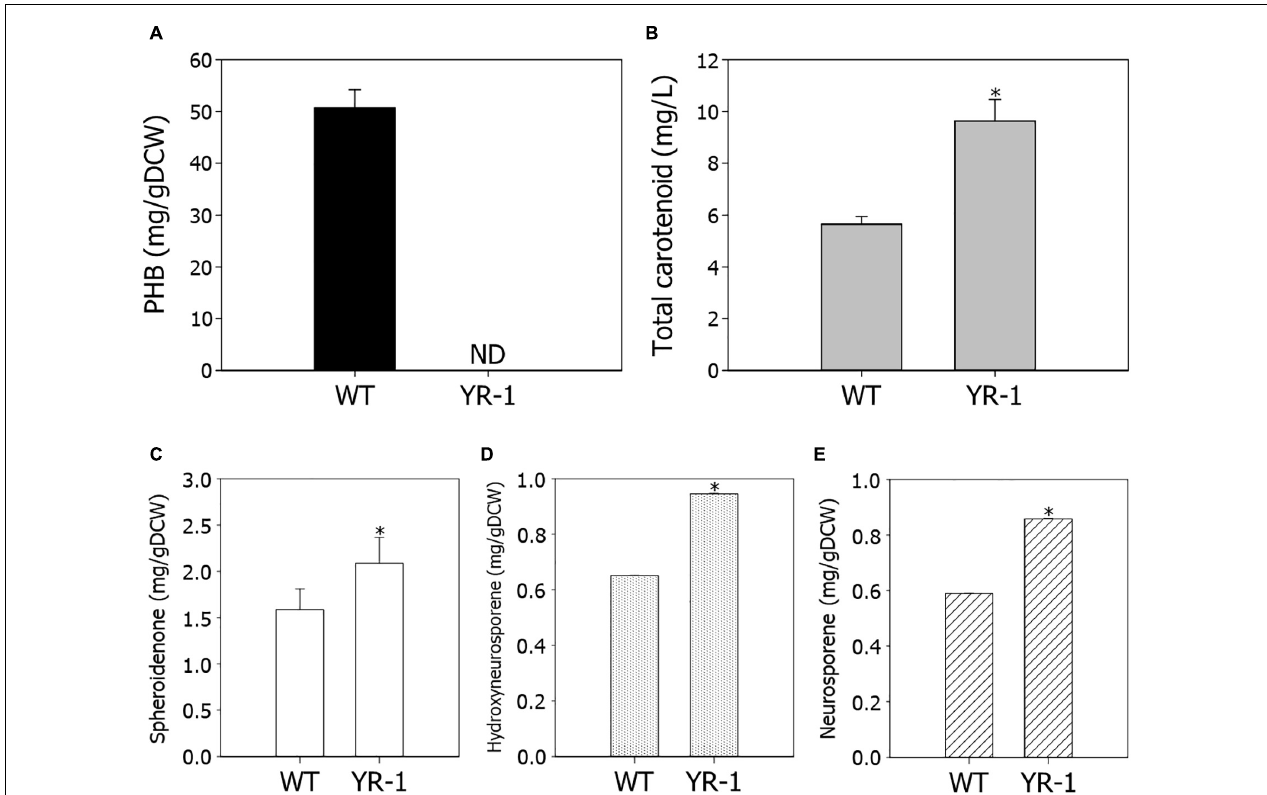
FIGURE 5 | Measurement of metabolite production in the wild-type and YR-1 mutant. (A) Contents of PHB. (B) Concentrations of total carotenoids. (C) Contents of spheroidenone. (D) Contents of hydroxyneurosporene. (E) Contents of neurosporene. Analyses were performed in triplicate and error bars indicate standard deviation of mean. Asterisk represents statistically significant difference, as determined by a Student t -test ( ∗ P < 0.05).